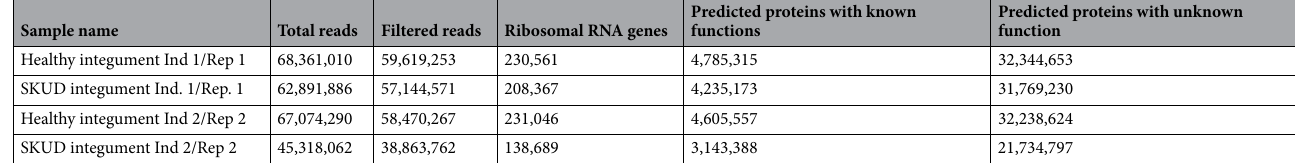
Table 2. Raw and filtered reads and global annotation using the MG-RAST pipeline. Total Reads: Total number of sequence reads analysed for each sample. Raw reads were submitted on NCBI under the Bioproject PRJNA634538. Legend: SKUD integument: dorsal integument affected by the SKUD (i.e. ulcer); Healthy integument: healthy dorsal integument of a SKUD-affected individual; Ind.: individual; Rep.: